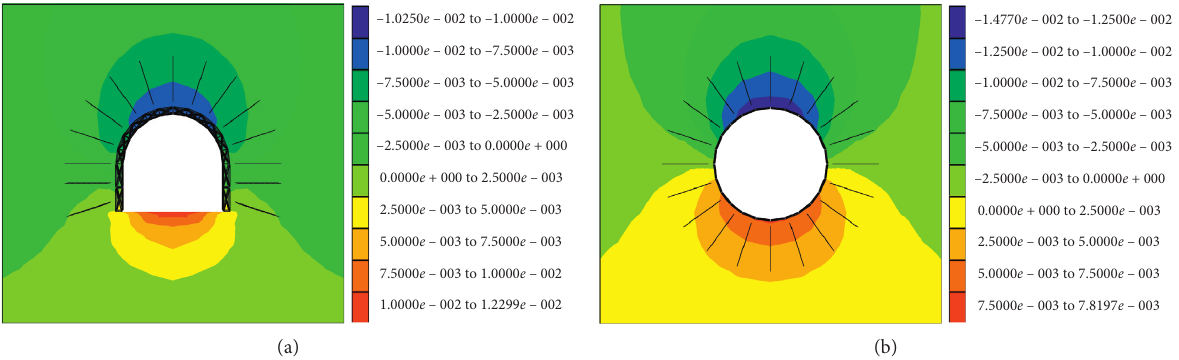
Figure 10: Displacement contours of roadway in excavation of 6m. (a) Semicircular arch roadway. (b) Circle roadway.